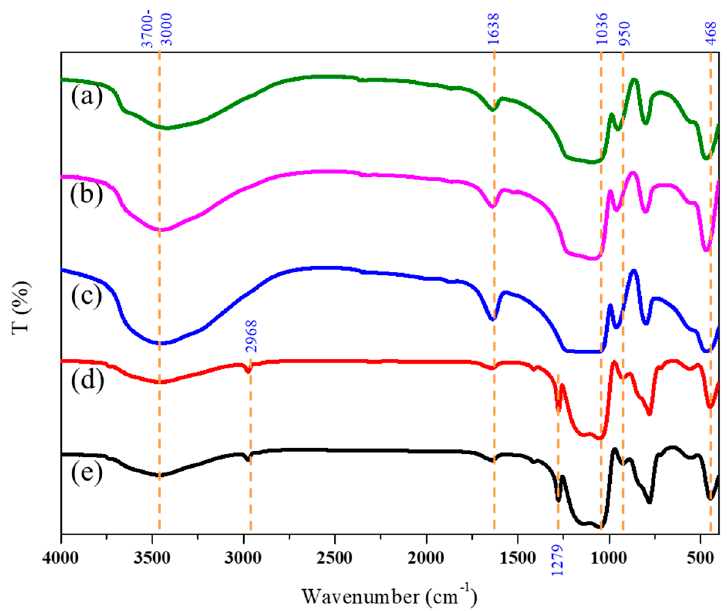
Figure 1. ATR-FTIR spectra of the hydrophilic ( a ) A1, ( b ) A2, and ( c ) A3 MSPs, as well as the hydrophobic ( d ) M1 and ( e ) M2 MSPs.